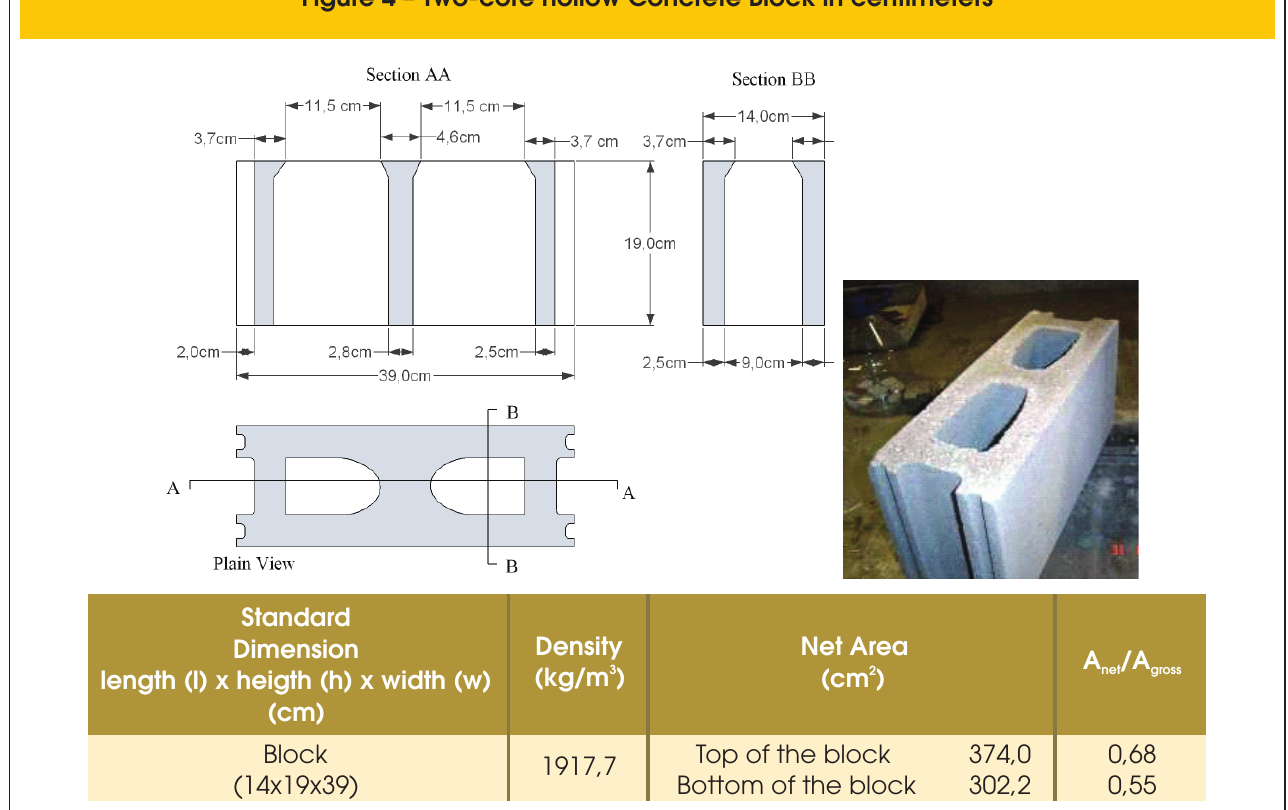
Figure 4 – Two-core hollow Concrete Block in centimeters